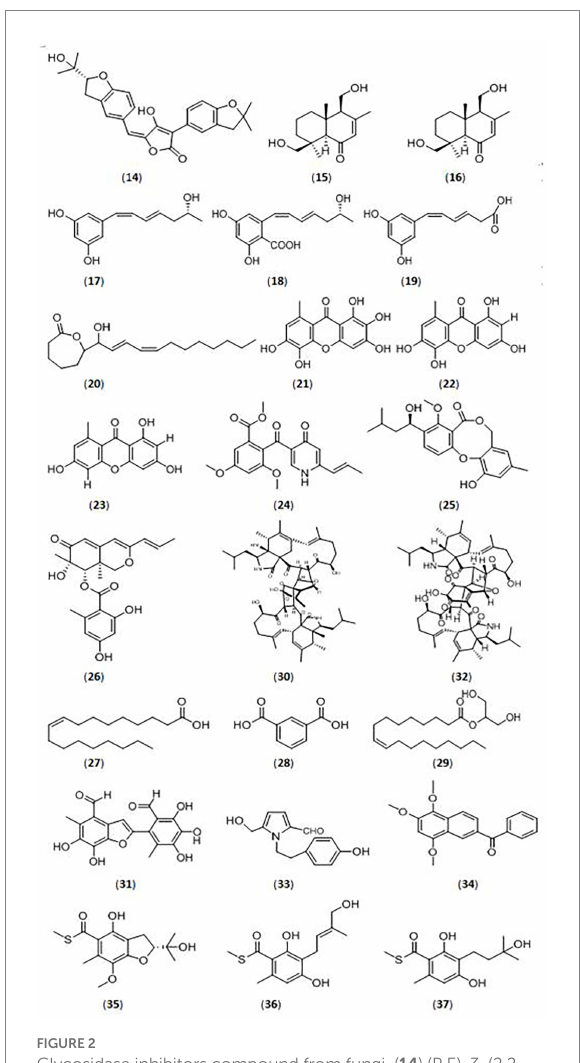
FIGURE 2 Glycosidase inhibitors compound from fungi. ( 14 ).(R,E)-3-(2,2- dimethyl chroman6-yl)-4-hydroxy-5-((2-(2-hydroxypropan-2- yl)-2,3-dihydrobenzofuran-5-yl)methylene) furan-2(5H)-one; ( 15 ).(4S,5R,9S,10R)-11,13-dihydroxy-drim-7-en-6-one; ( 16 ).5-((R,1Z,3E)-6-hydroxy-1,3-heptadien-1-yl)-1,3-benzenediol; ( 17 ).4-carboxy-5-((R,1Z,3E)-6-hydroxy-1,3-heptadien-1-yl)- 1,3-benzenediol; ( 18 ).4-carboxy-5-((1Z,3E)-1,3-heptadien1-yl)- 1,3-benzenediol; ( 19 ). (1Z,3E)-4-carboxy-1,3-butadienyl-1-yl)- 1,3-benzenediol; ( 20 ). ε -caprolactone derivative; ( 21 ).unreported xanthone; ( 22–23 ).xanthones; ( 24 ).vermistatin; ( 25 ).penicillide; ( 26 ).Sch725680; ( 27 ).oleic acid; ( 28 ).1,3-benzenedicarboxylic acid; ( 29 ).hexadecanoic acid; ( 30 ).asperchalasine I; ( 31 ). epicoccolide B; ( 32 ).asperchalasine A; ( 33